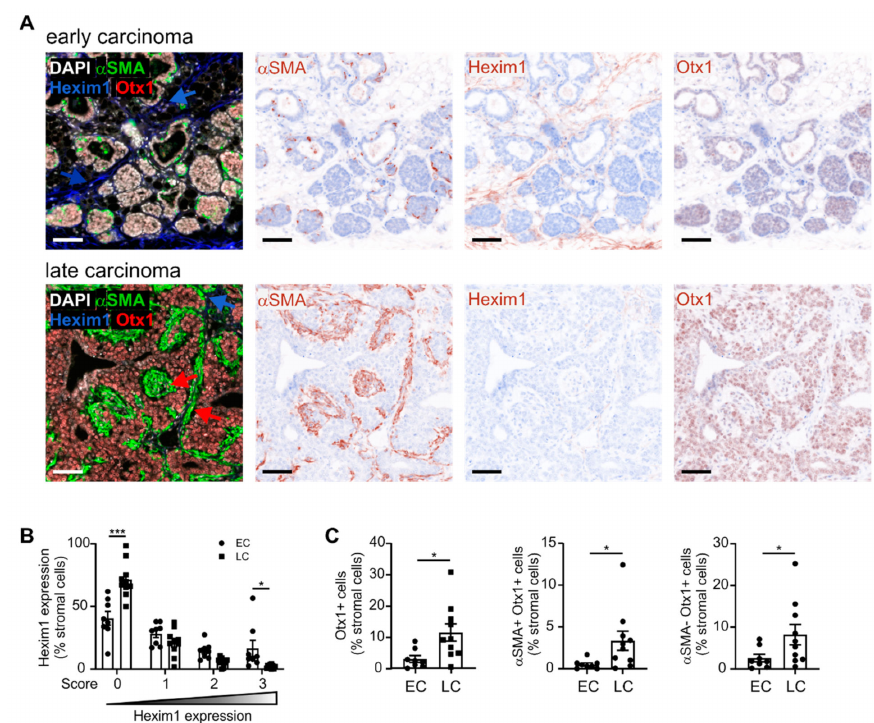
Figure 6. Histological validation of early versus late cancer-associated fibroblast (CAF) signature. ( A ) Early- and late-stage PyMT tumors were harvested and analyzed for expression of the activated fibroblast marker, as well as the predicted early CAF marker Hexim1 and the late CAF marker Otx1 using PhenOptics. Nuclei were counterstained with DAPI. Representative images show combined expression of all markers as well as expression of single markers. Scale bars: 50 µ m. ( B ) Hexim1 expression in total stromal cells is shown. ( C ) Otx1 expression in total stroma, α SMA + stromal cells, and α SMA- stromal cells is displayed. Individual data points indicate mean expression of markers in tissue sections of one individual animal. Additionally, means ± SEM are shown. p -values were calculated using one-way ANOVA with Bonferroni’s correction, * p < 0.05, *** p <